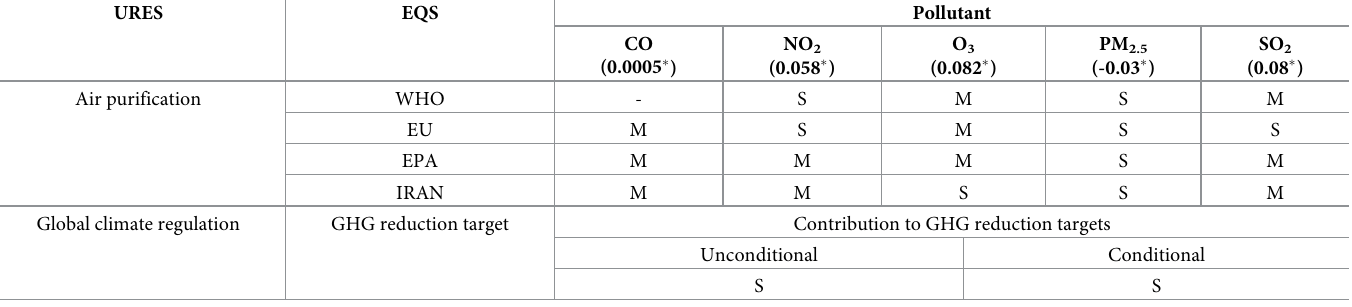
� : Average percentage of air quality improvement (%) by UF. These values are shown here to explain the relation between the air quality improvement provided by UF and the matches and mismatches. In other words, it helps to translate the magnitude of air quality improvement of each pollutant to level of mismatches or matches according to the associated EQS. For example, the 0.0005% improvement of CO resulted in matches according to all